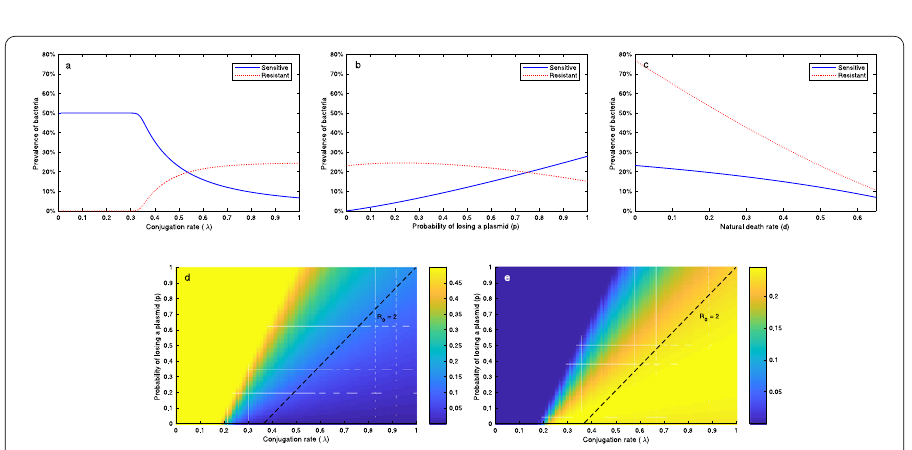
Figure 3 Effectsofvitalparametersontheprevalenceoftwobacterialtypes . Parameters, unless varied, are set according to Table 1. Results are obtained at the steady state when ( a ) the conjugation rate λ is varied, ( b )